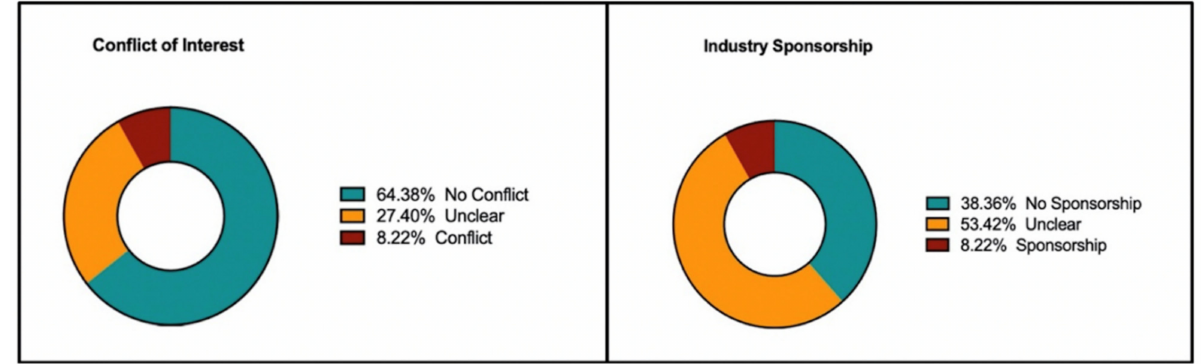
Figure 4. Prevalence of conflict of interest and industry sponsorship.